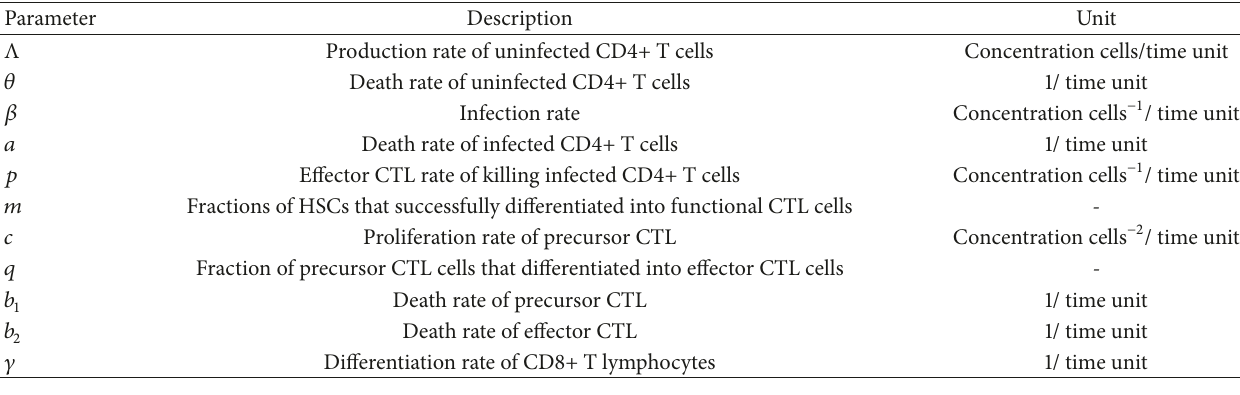
Table 1: The description of parameters in the